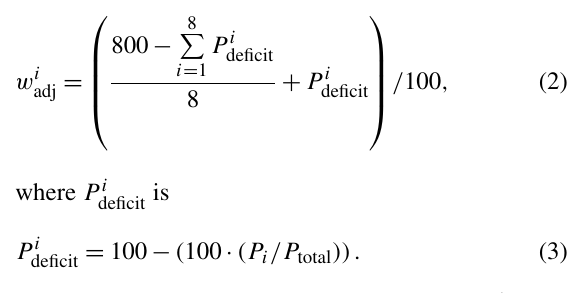
time series is filtered by interpolating the grids outside the perimeter and any of the grids inside the farm.